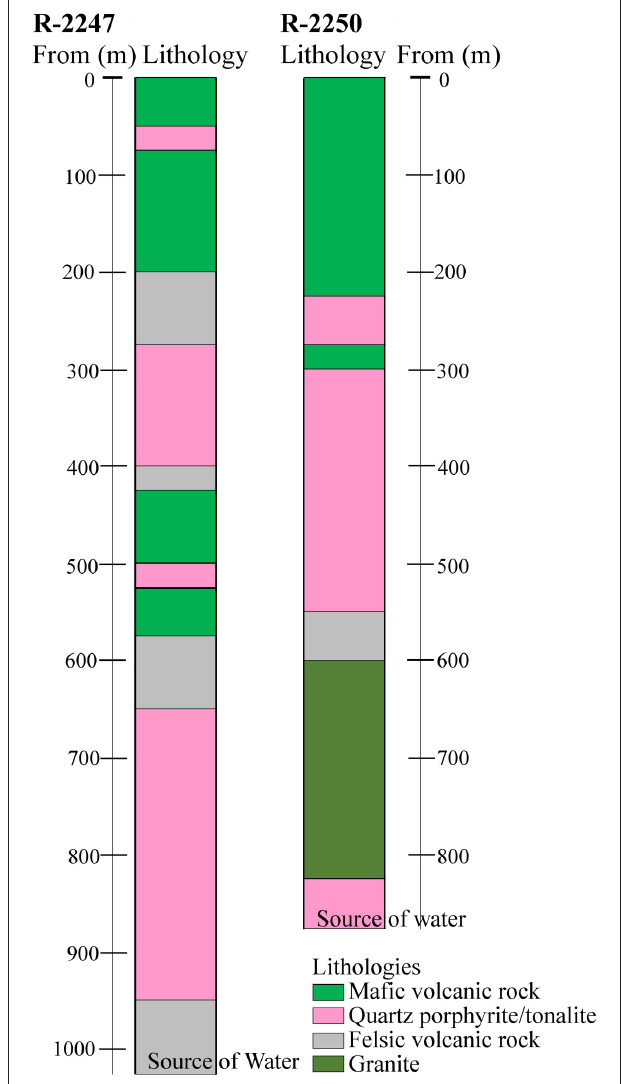
FIGURE 2 | Generalized lithologies in drill holes R-2247 and R-2250 starting from the mine levels of 1430m and 1350m below ground